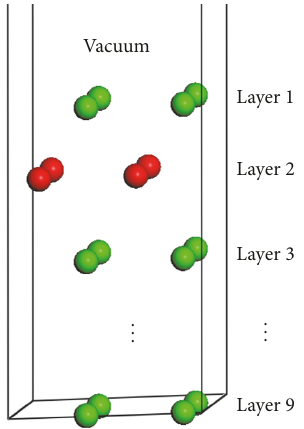
Figure 2: Side view of U(001) nine-layer slabs.